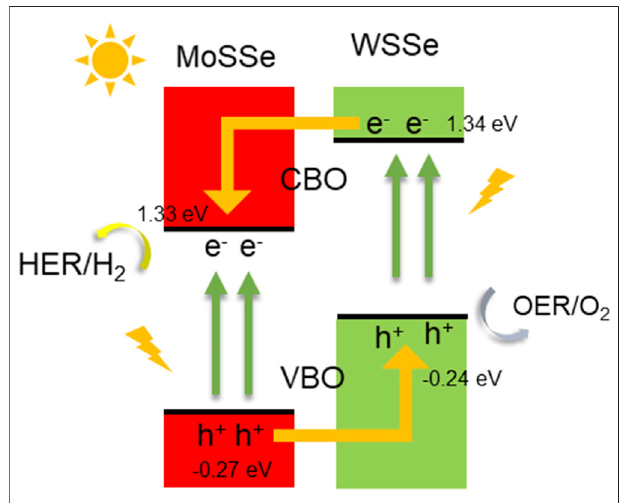
FIGURE 4 | Schematic of the exciton migration mode of the lateral MoSSe/WSSe heterostructure.